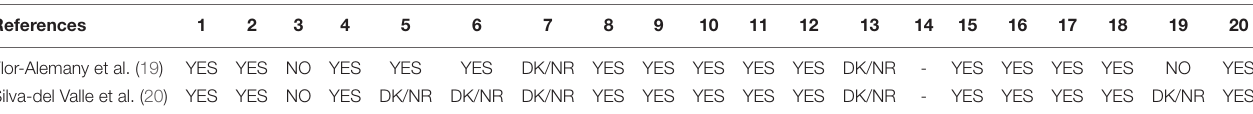
TABLE 2 | First ten questions of the AXIS tool.